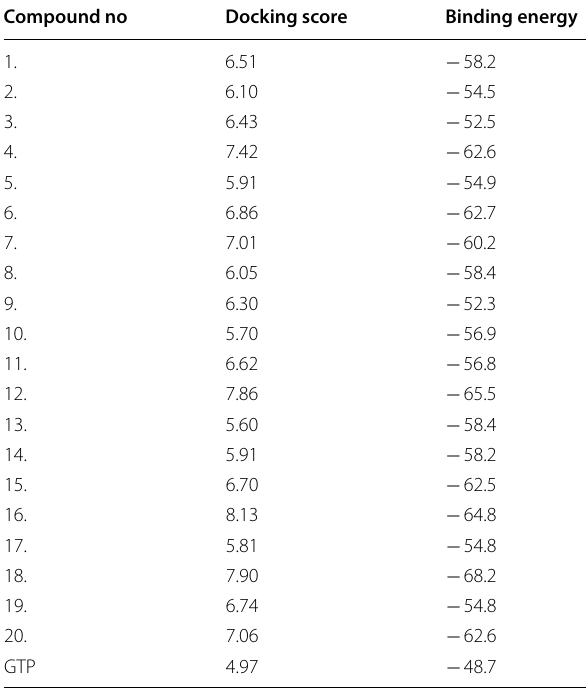
Table 4 Docking score and binding energy of bis- pyrimidine derivatives Compound no Docking score Binding